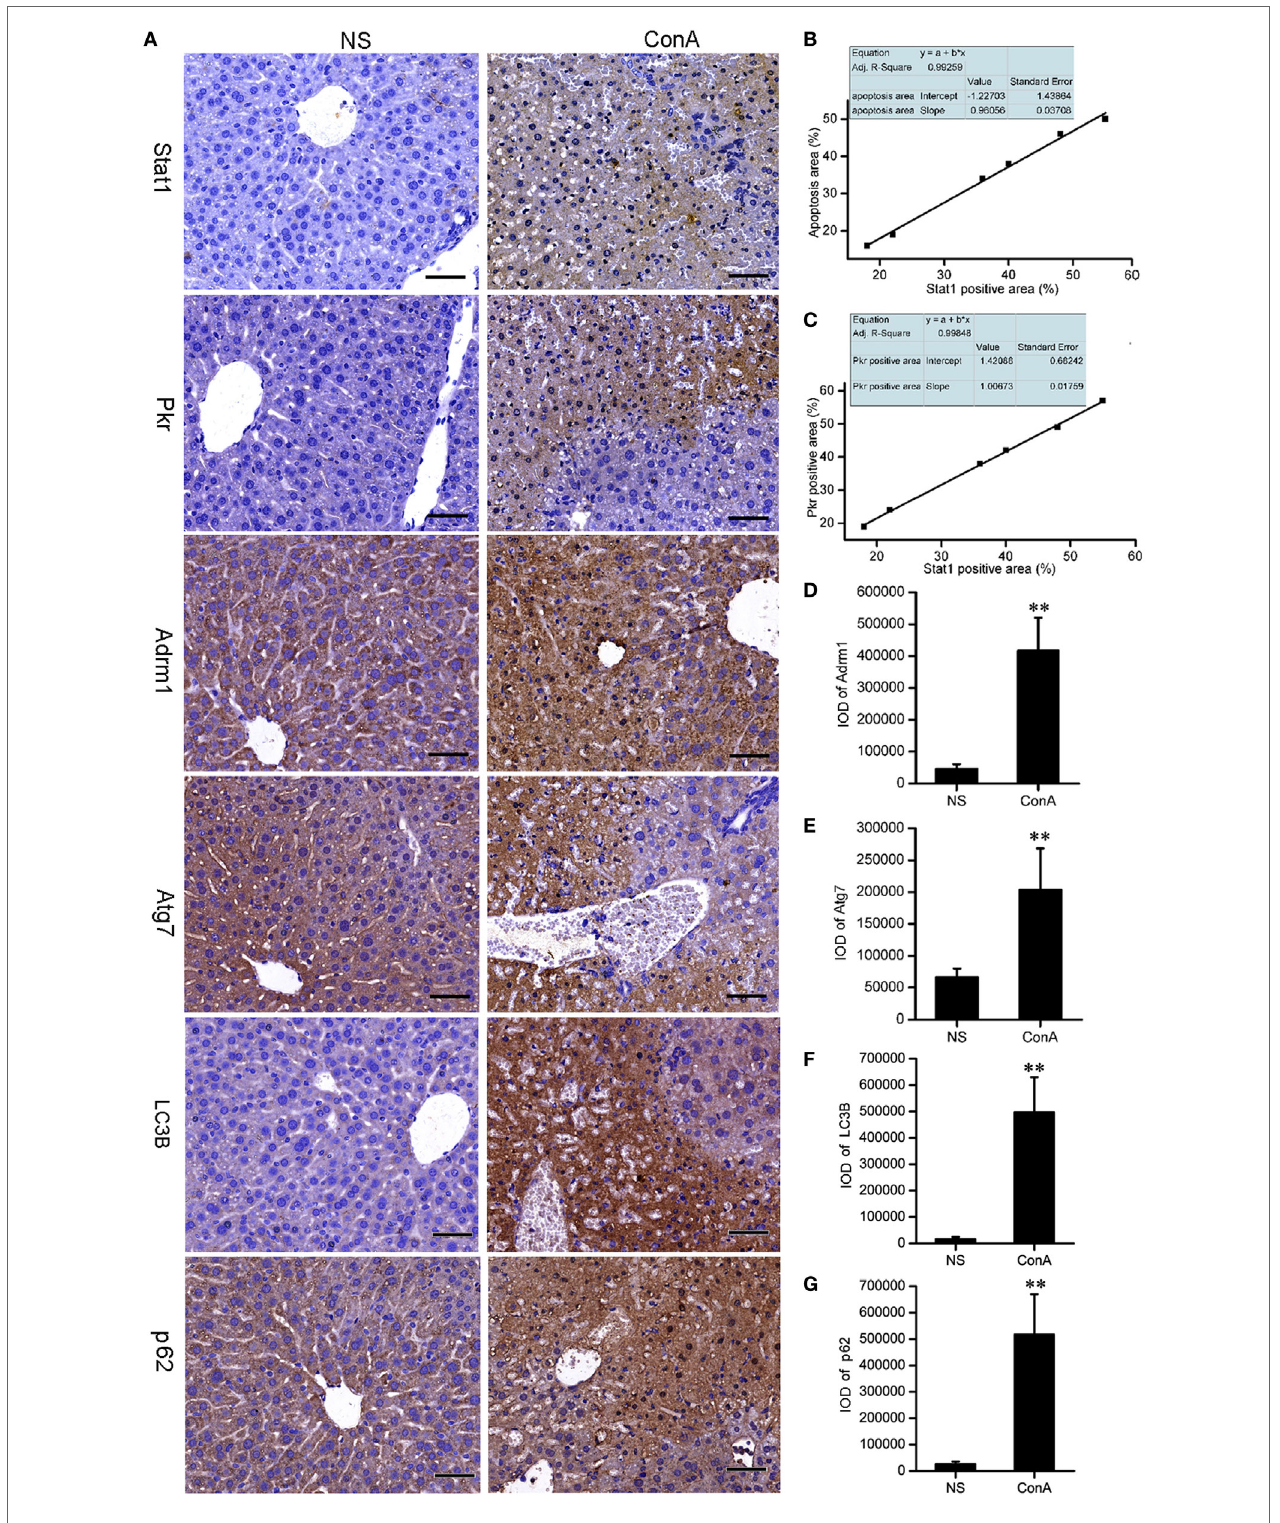
FigUre 3 | The validation of the proteomic data of Stat1, Pkr, Atg7, and Adrm1 by IHC. The LC3B and p62 were detected by IHC. (a) The IHC of Stat1, Pkr, Atg7, Adrm1, LC3B, and p62 of control mice and model mice. Positive correlations of Stat1 with apoptosis (B) , Stat1 with Pkr (c) in the sections of ConA treatment group were shown. Integrated optical density of Adrm1 (D) , Atg7 (e) , LC3B (F) , and p62 (g) showed that they were upregulated after ConA treatment. ** p < 0.01 compared with the control group ( n = 6).